Question: Judging by this figure, is the value going up or going down?
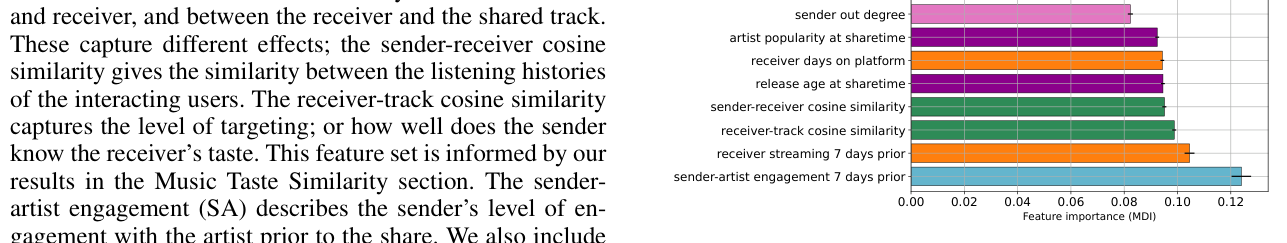
Answer: decreasing